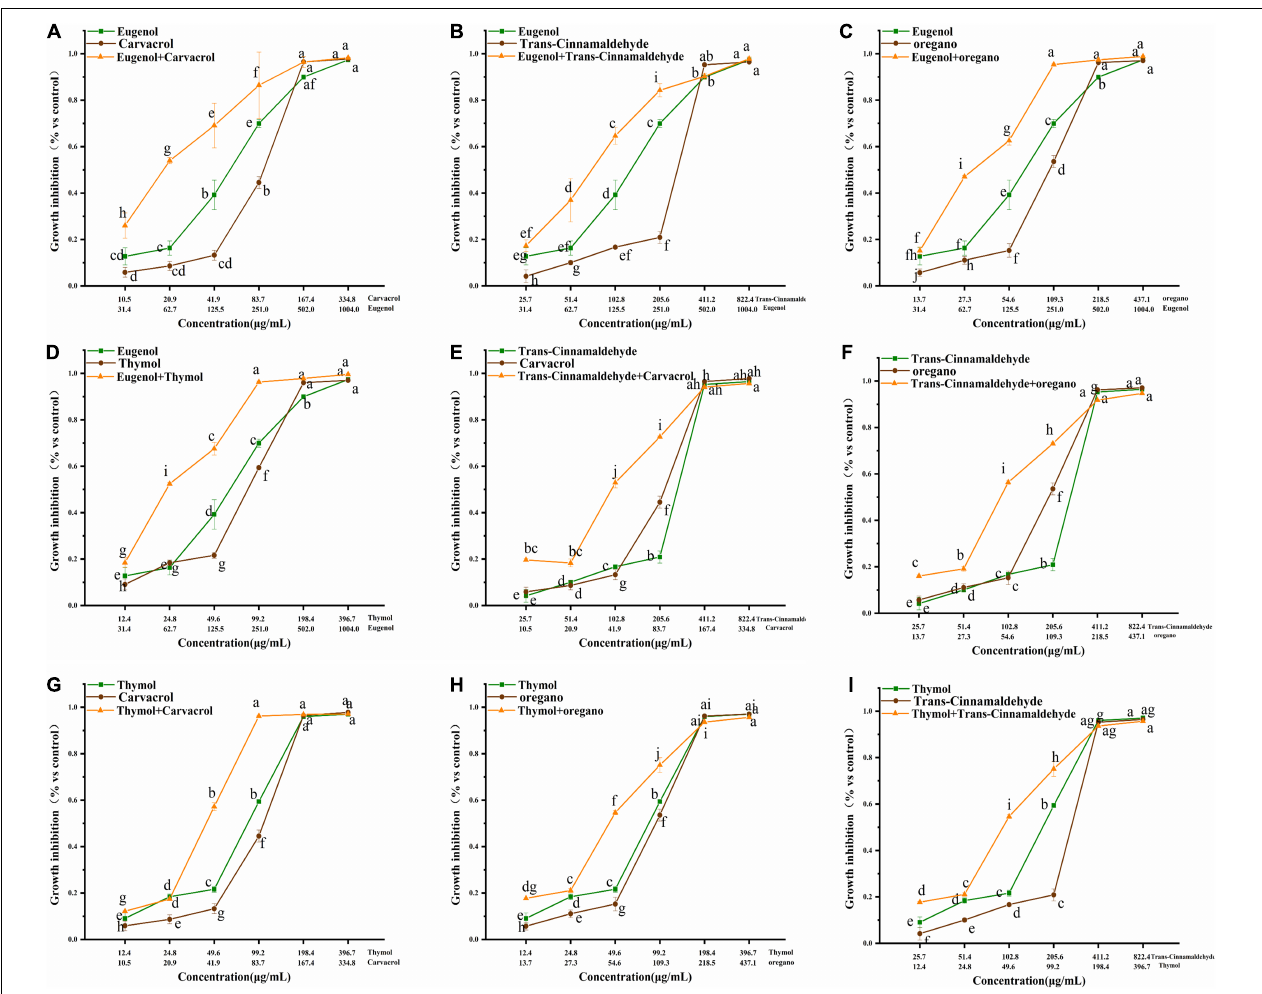
FIGURE 1 | (A–I) Effect of single and combined of natural antimicrobials on the growth inhibition rate of Salmonella pullorum BNCC 19945. The significant differences among different concentrations or individual and combinations were analyzed using one-way ANOVA, followed by Duncan multiple comparisons ( P < 0.05 represent significant differences). The differences between various concentrations and groups are marked by letters: the same letter represent no differences, while different letter indicate significant